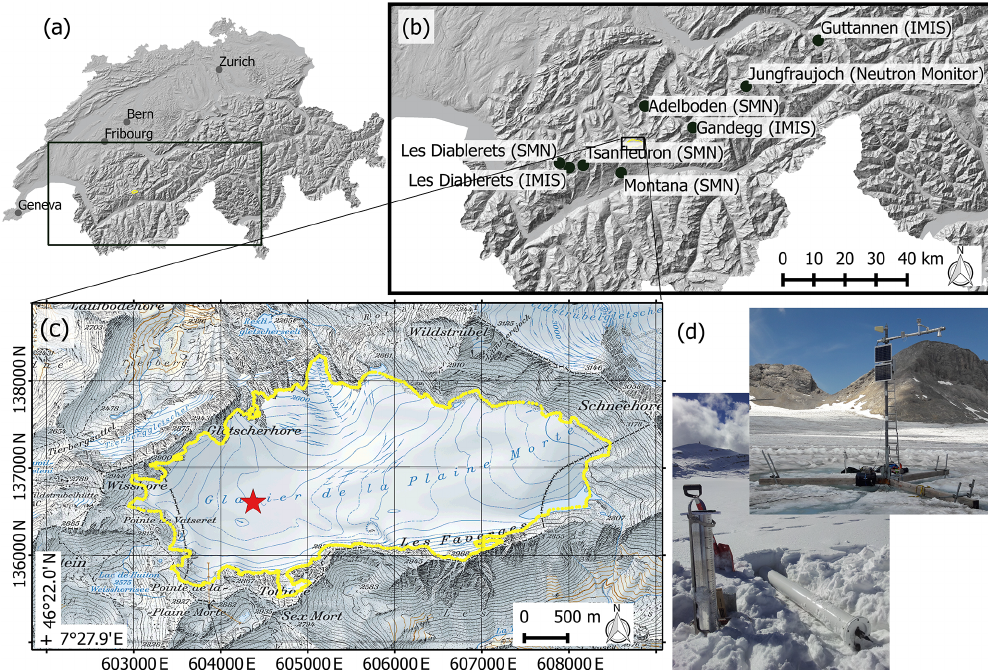
Figure 1. (a) Map of Switzerland. (b) Map of the excerpt marked in (a) and all weather stations used in this study (black dots). (c) Topo- graphic map of Plaine Morte with the red star indicating the location of the AWS with the CRS (see d , 46 ◦ 22.8 (cid:48) N, 7 ◦ 29.7 (cid:48) E). The yellow contour represents the current outline of Plaine Morte (Fischer et al., 2014). The coordinates correspond to the Swiss coordinate system (EPSG: 21781; maps provided by